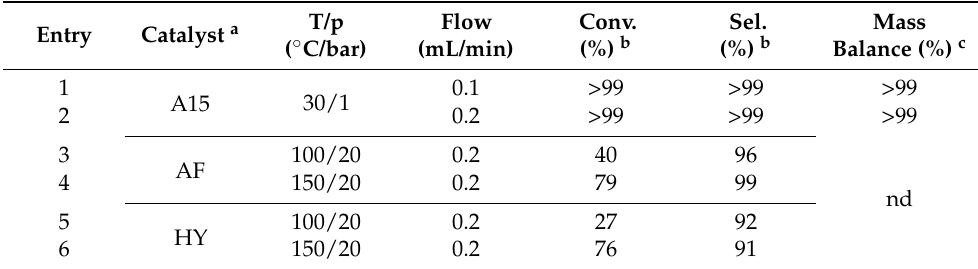
Table 2. The CF-acetalization of amide 1a over different